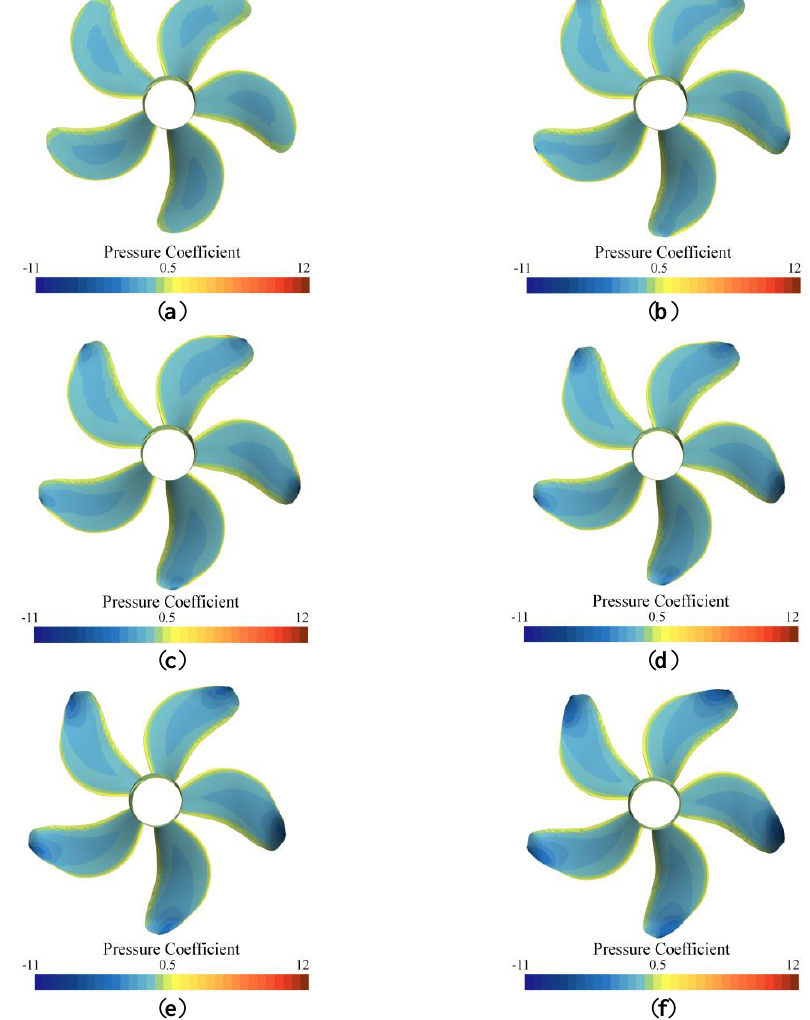
Figure 13. Pressure coefficient distribution on suction surface of propeller Kap00 ( a ), Kap01 ( b ), Kap02 ( c ), Kap03 ( d ), Kap04 ( e ) and Kap05 ( f ) ( J = 0.8, 12 rps, and σ = 2.0).